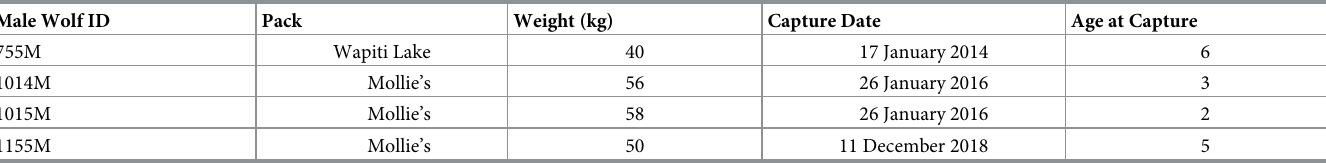
Table 1. Weight of notable male wolves.